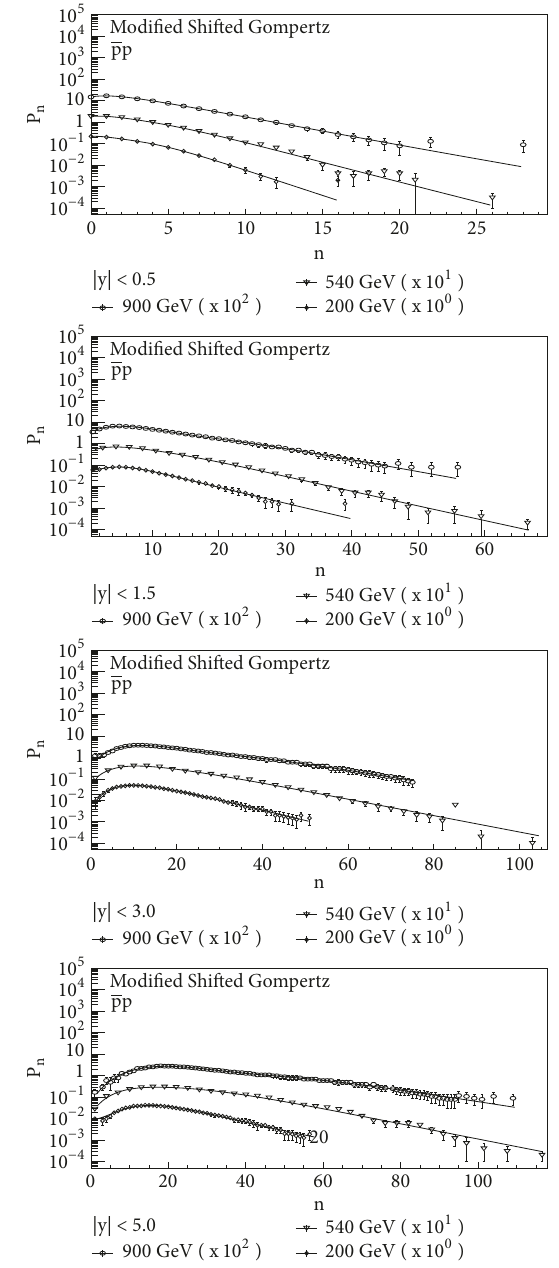
Figure 4: Charged multiplicity distributions in 𝑝𝑝 collisions in four rapidity windows. Solid lines represent modified shifted Gompertz